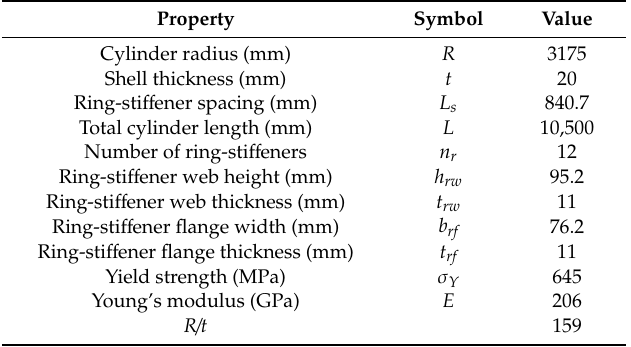
Table 5. Properties of the ring-stiffened cylinder considered in case study.